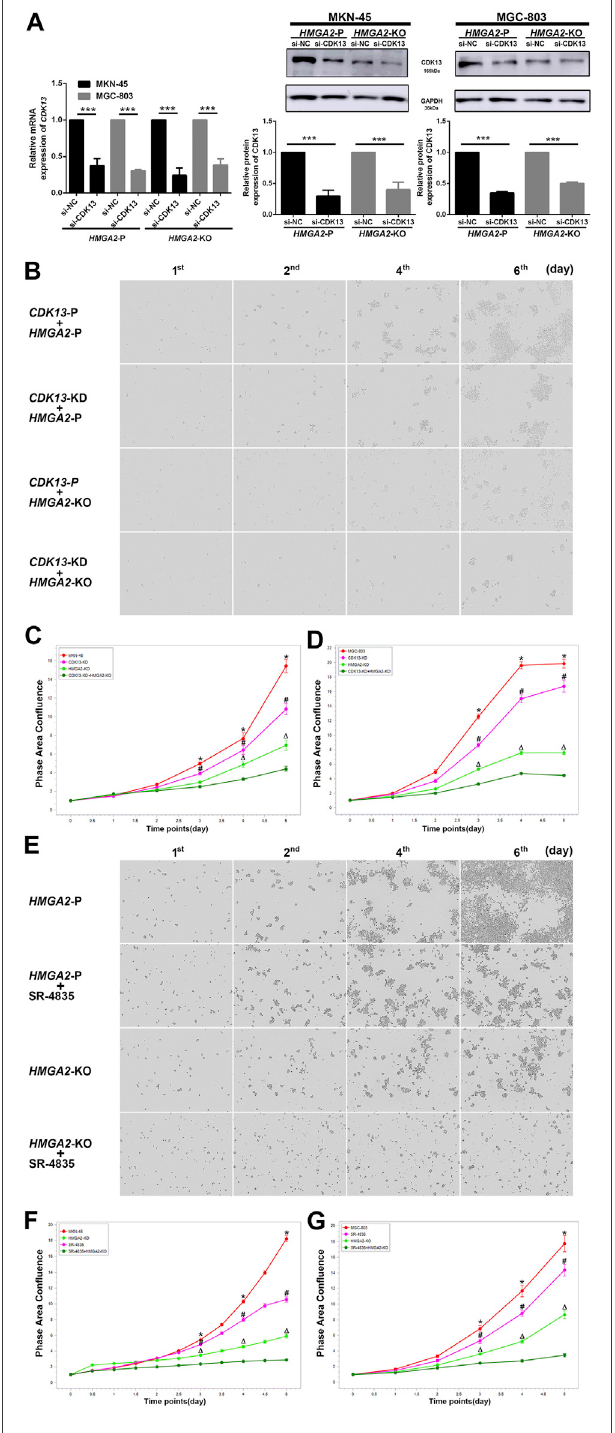
FIGURE 6 | Inhibiting CDK13 and HMGA2 simultaneously suppresses theGCcellsmost. (A) Ef fi ciencyofknockingdownCDK13intwoGCcelllines. Left: the ef fi ciency was veri fi ed by RT-PCR. CDK13 was knocked down based on HMGA2 -P and HMGA2 -KO MKN-45/MGC-803, respectively. X -axis: different cell groups. Y -axis: expression of CDK13 . Middle and right: western blot results of the expression of CDK13 in HMGA2 -P and HMGA2 -